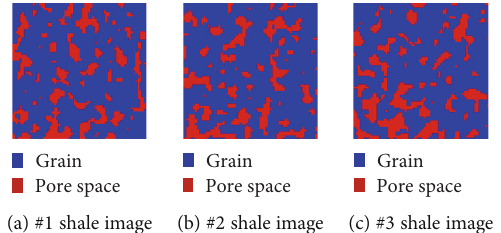
Figure 4: Some shale cross-section images from real volume data.